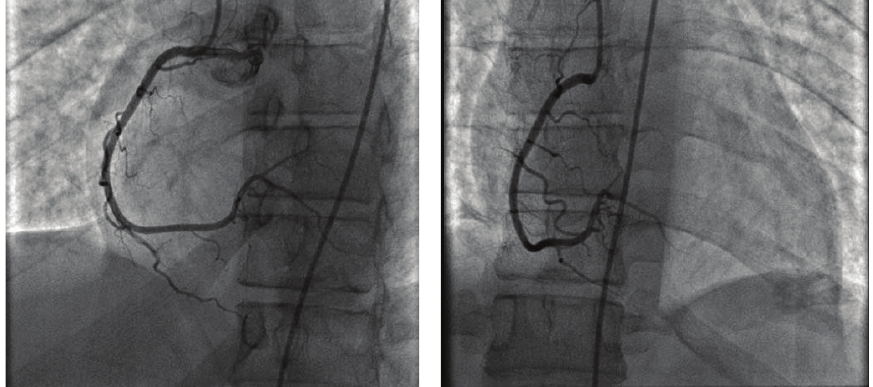
Figure 4: Normal